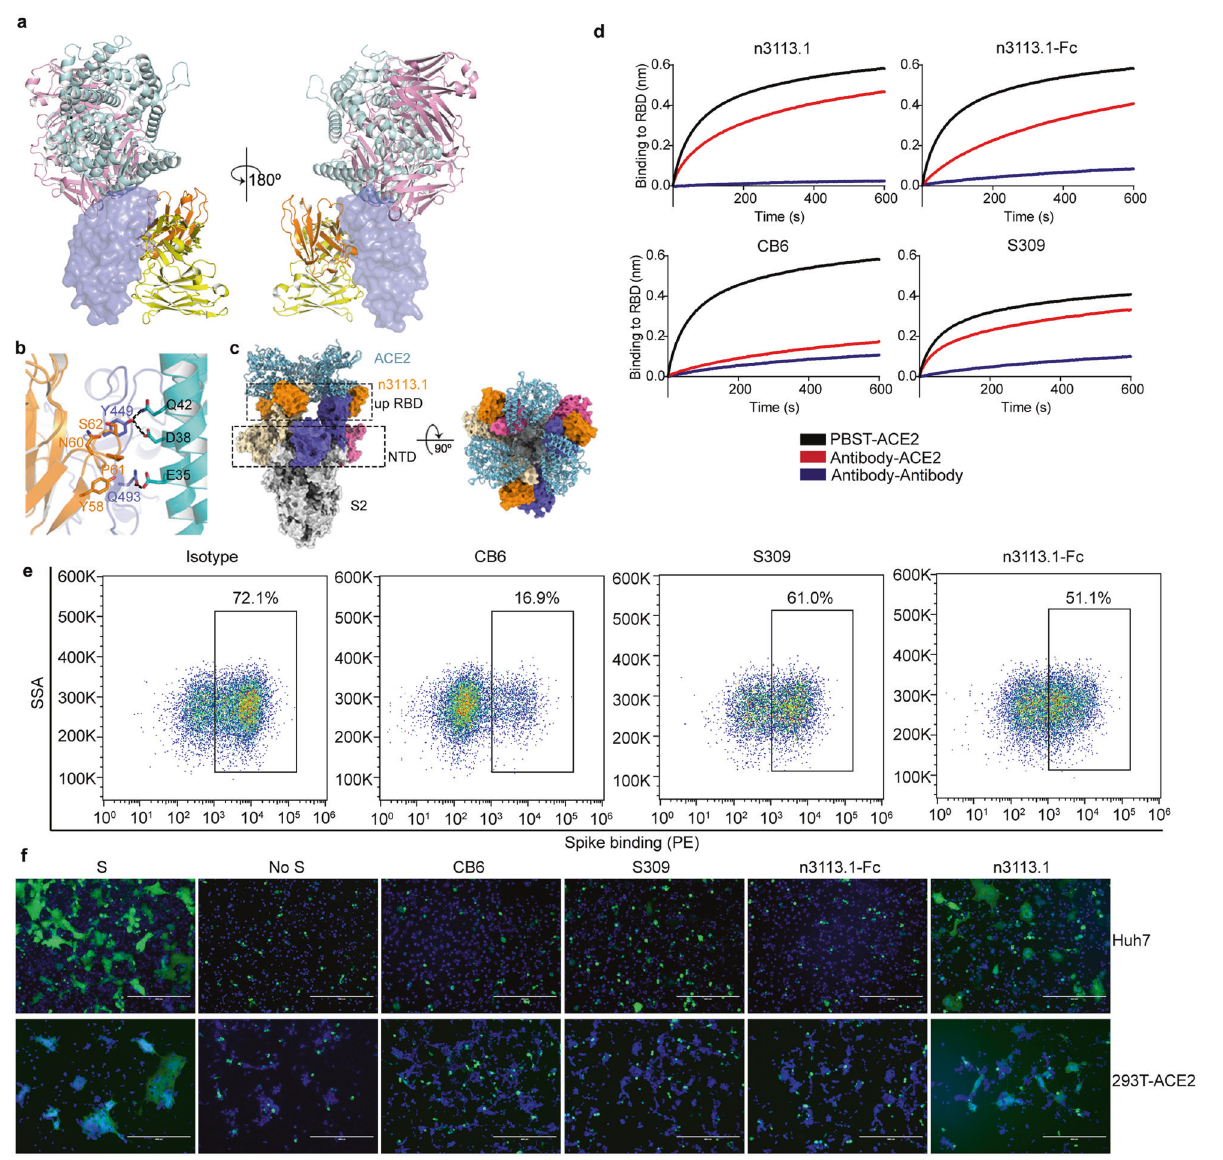
neutralization assay presented the same result (Fig. 4e). N3113.1- Fc neutralized pseudoviruses loaded with a spike of WT-D614G and Alpha variant in indiscriminate potent (IC50 of 0.07 μ g/ml and 0.12 μ g/ml for WT-D614G and Alpha, respectively, Fig.